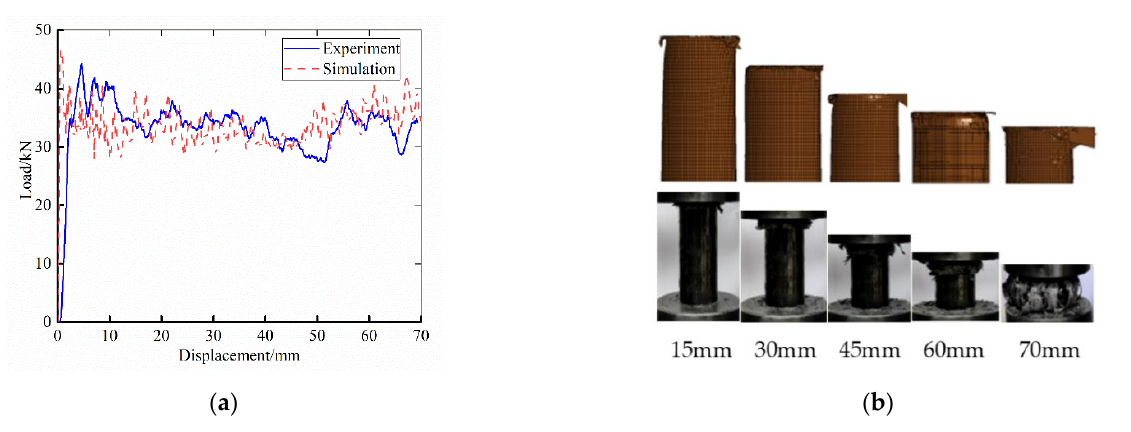
Figure 8. Simulation and experiment comparison of the CFRP tube: ( a ) load – displacement curve; ( b ) comparison of deformation modes.